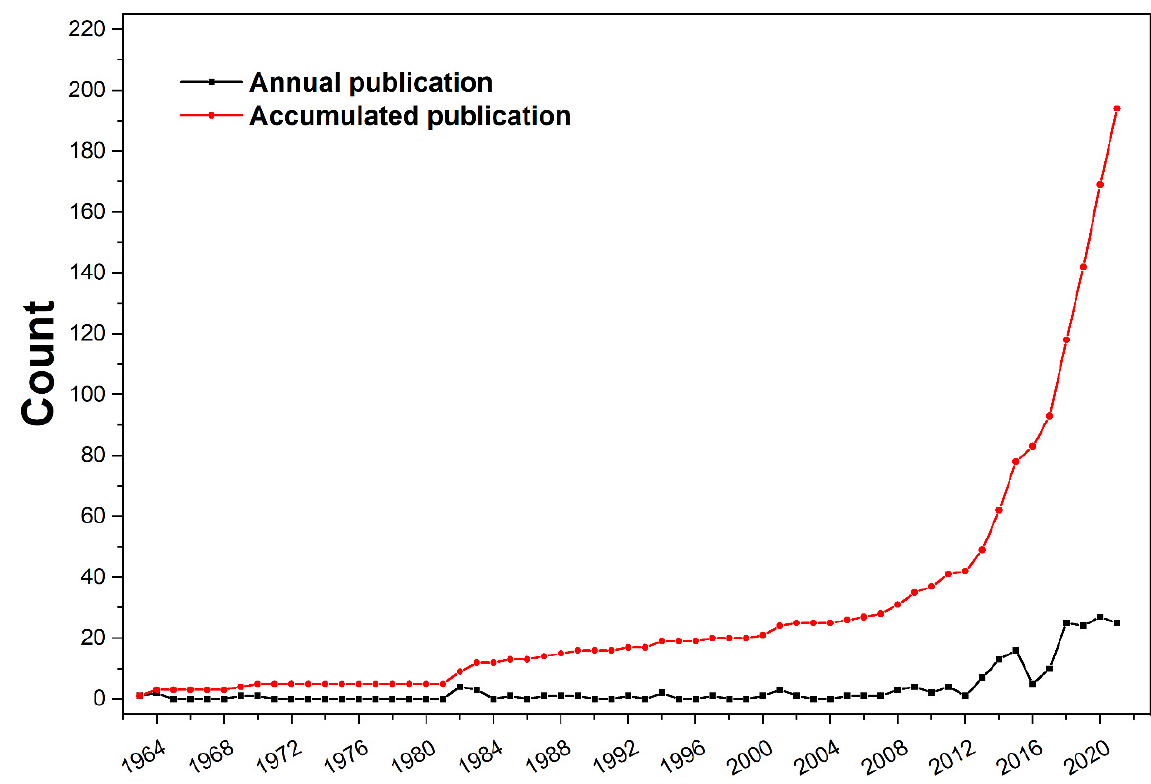
Figure 2. Annual and accumulated publications from 1963 to 2021 searched in the Web of Science about flame-retardant RPUF.